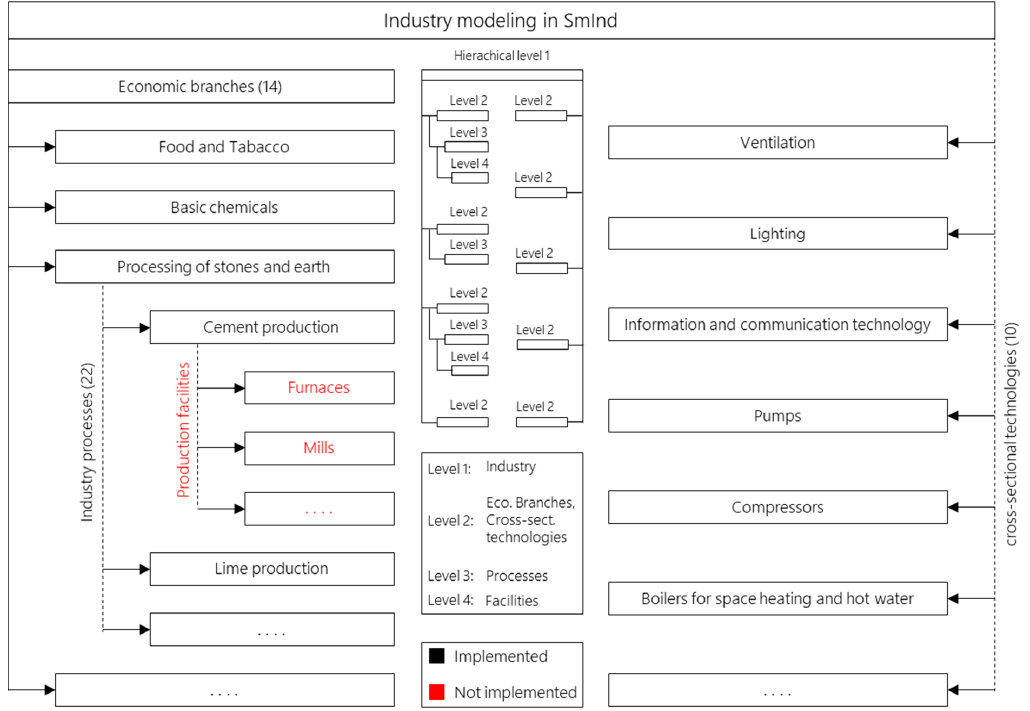
Figure 1. Industrial technology modelling in SmInd. Terms written in black are already implemented in